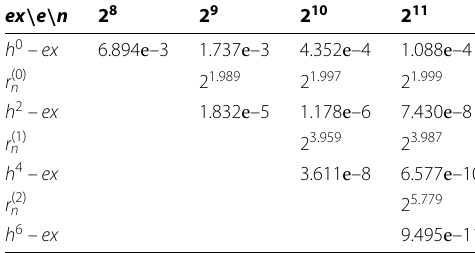
Table 2 The numerical results for t =